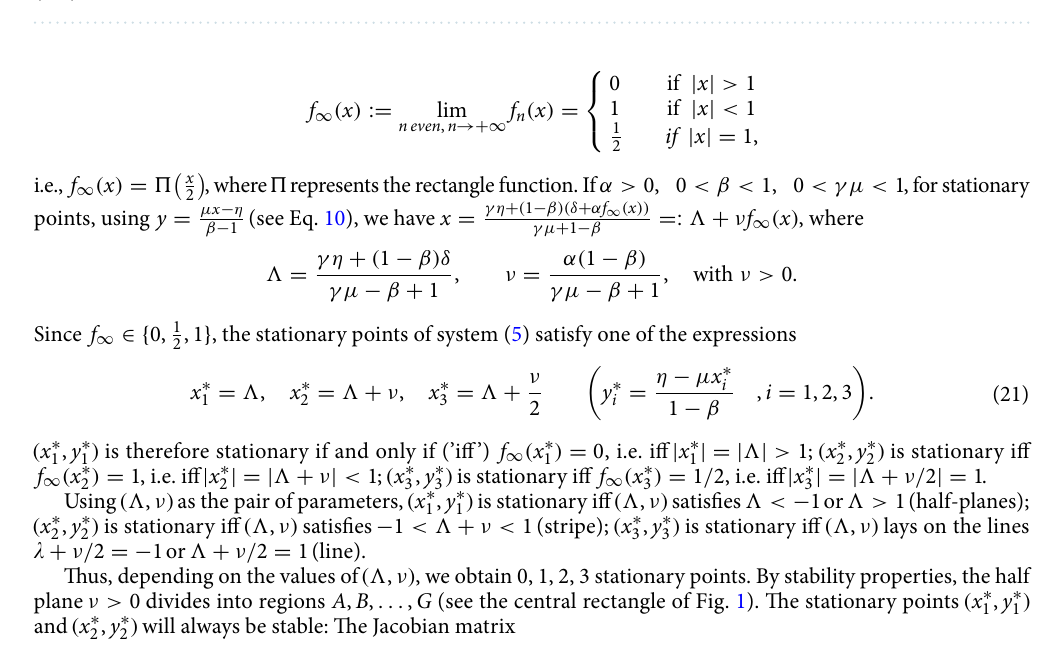
Figure 1. Center panel: Stationary states of system (5) in the (� , ν) plane. Small figures: Exemplary illustrations x , y using vector fields on the state-space with locations of stable fixed-points (green) and unstable fixed-points { } (red)